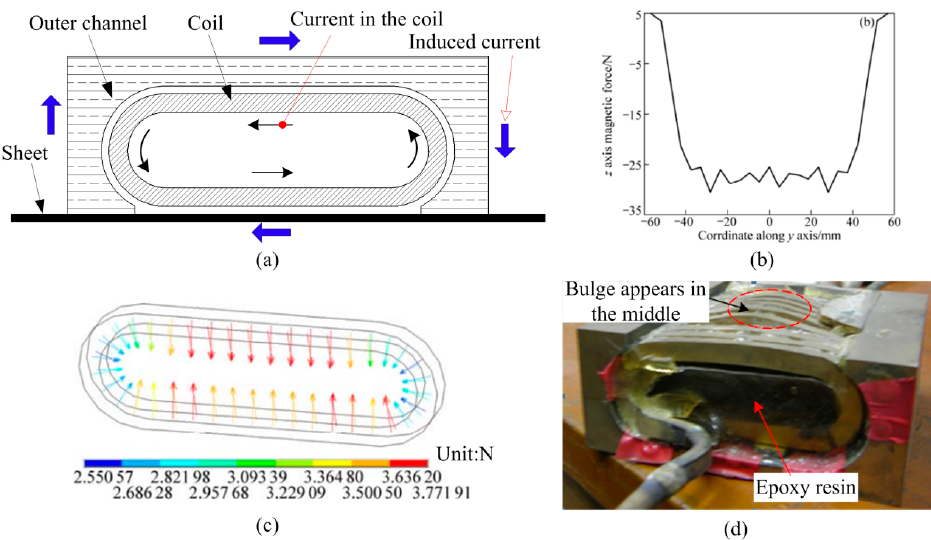
Figure 1. Traditional uniform-pressure coil. ( a ) Design principle, ( b ) magnetic force on sheet [17], ( c ) magnetic force on a coil [17], and ( d ) failure of a coil [18].